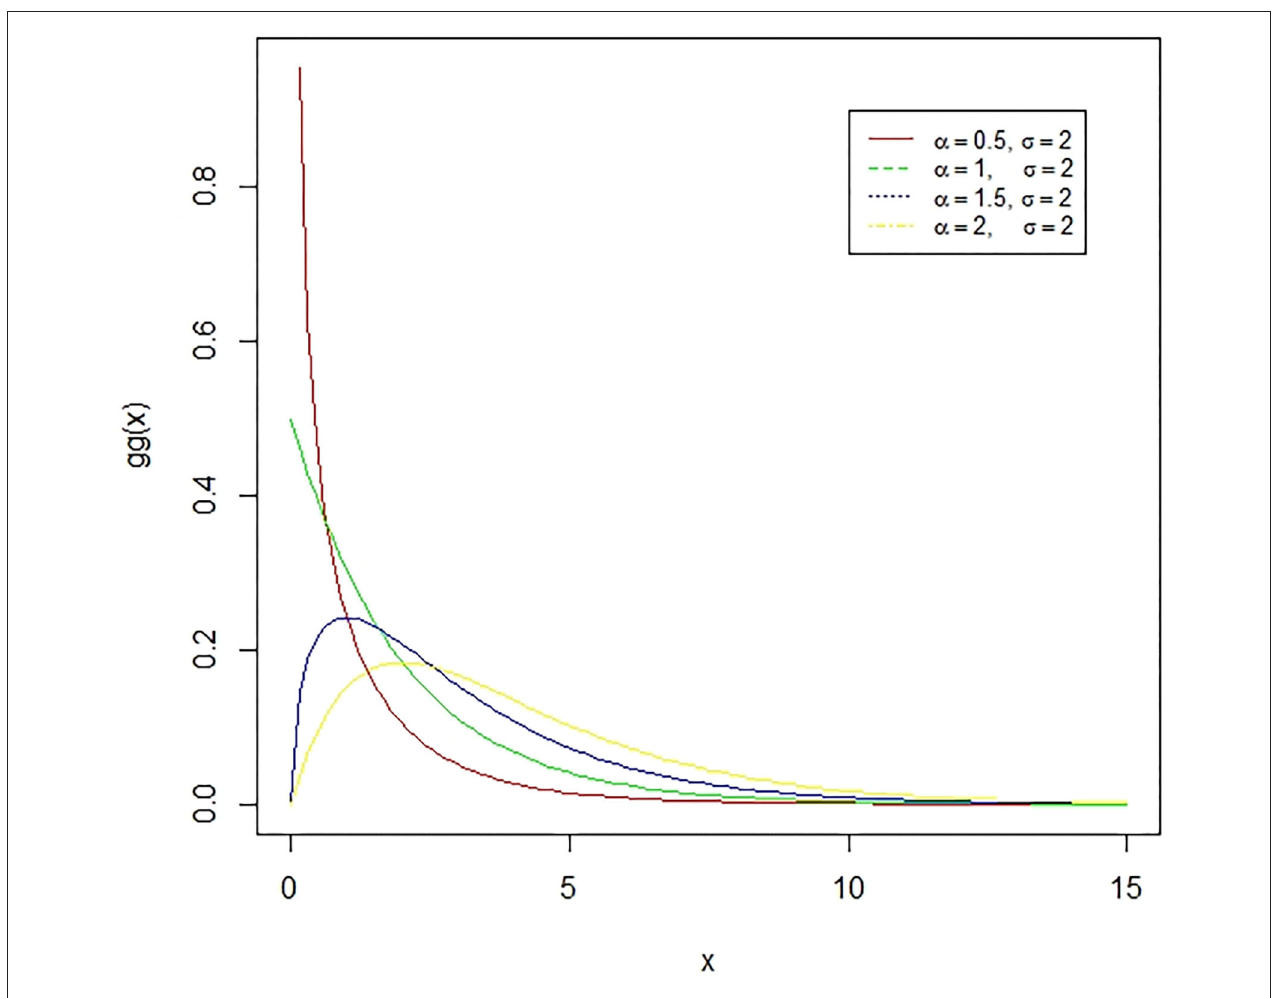
is fixed and greater than zero, and E [ log ( X )= ψ ( κ ) + log( κ ) = σ